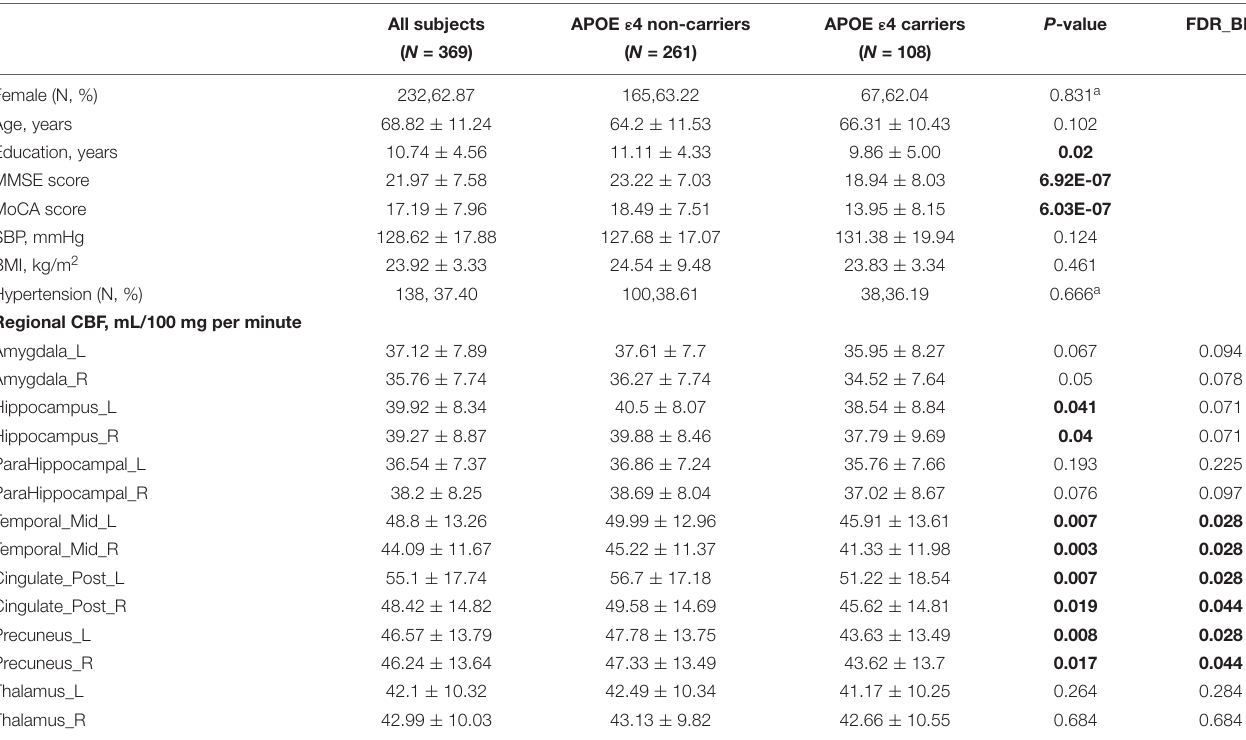
TABLE 1 | Characteristics of